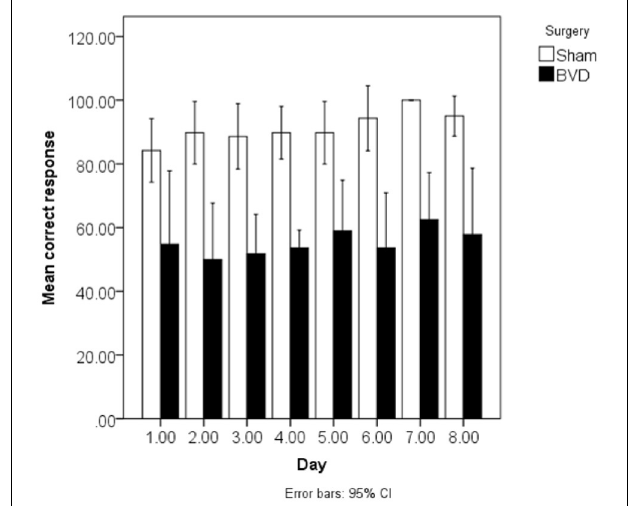
FIGURE 3 | Mean % correct responses in the spatial T maze task in light over 8 days for the BVD and sham animals at 4–5 months post-op. Reproduced with permission from Zheng et al. (2012a,b). Data are expressed as means ± a 95% confidence interval.